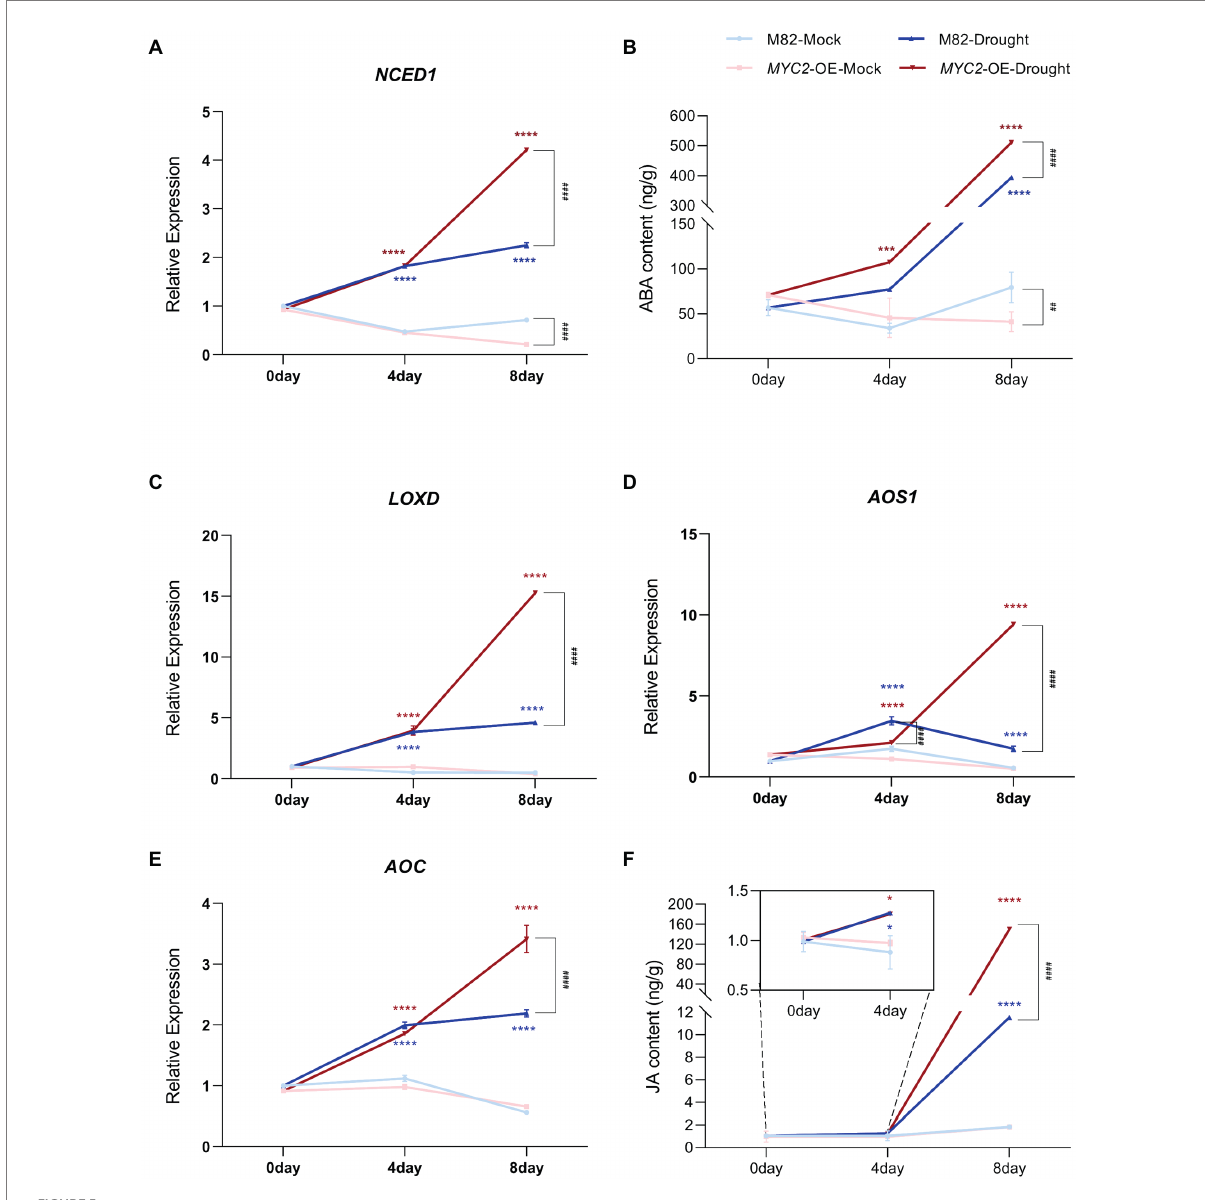
FIGURE 5 SlMYC2 promoted ABA and JA biosynthesis in plants under drought stress. (A,C–E) NCED1, LOXD, AOS1 and AOC expression patterns in leaves of MYC2 -OE and M82 plants under drought stress and mock conditions. (B,F) The ABA and JA contents in leaves of MYC2 -OE and M82 plants under drought stress and mock conditions. Asterisks represent significant differences (* p < 0.01, *** p < 0.001, and **** p < 0.0001) between water loss and mock conditions in MYC2 -OE (red) or M82 (blue) plants; pound signs indicate significant differences ( ### p < 0.001 and #### p < 0.0001) between MYC2 -OE and M82 plants under the same treatment conditions, as determined using Tukey’s multiple comparisons